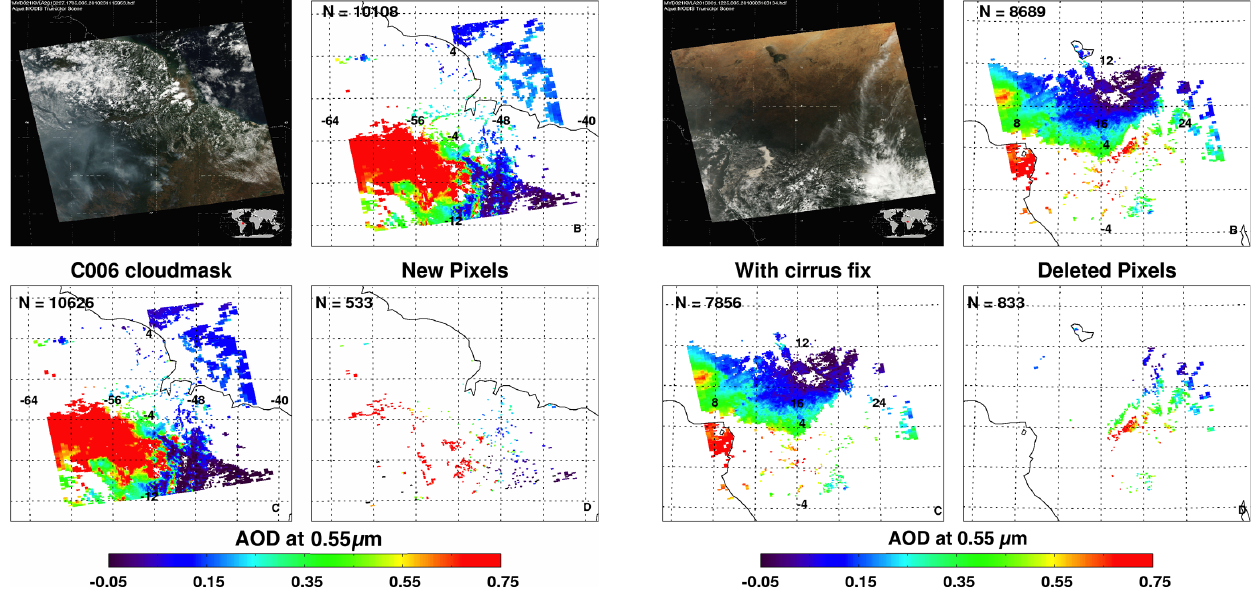
Fig. 8. Granule retrieved over northeastern South America from MODIS-Aqua on 15 August 2010 at 17:05UTC. Top left: true- color (RGB) showing smoke and cloud scene taken from modis- atmos.gsfc.nasa.gov. (b and c) Retrieved high quality (QAC=3 over land and QAC ≥ 1 over ocean) AOD at 0.55µm, without and with the 0.47µm cloud mask call-back (standard deviation test) over land. (d) New (smoke) pixels over land that have been reclaimed.